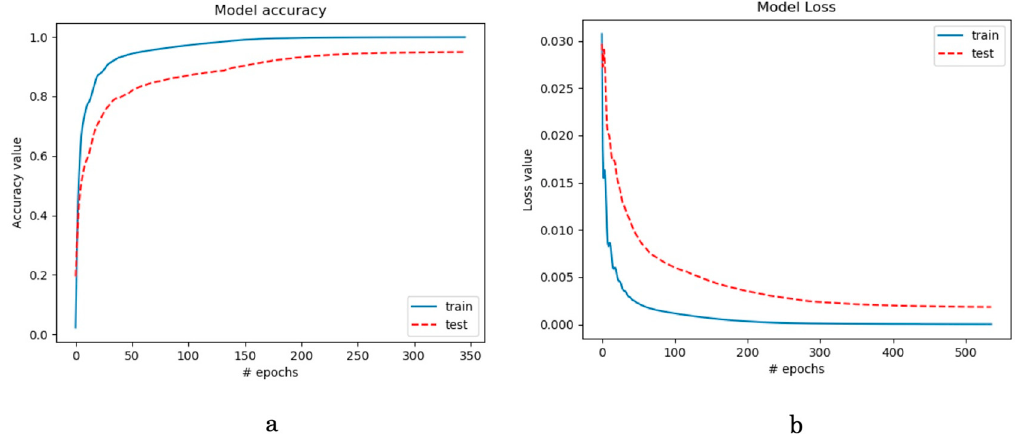
Figure 11. ANN regression plots for the Al-Besharah data. ( a ) Model Accuracy ( b ) Model Loss